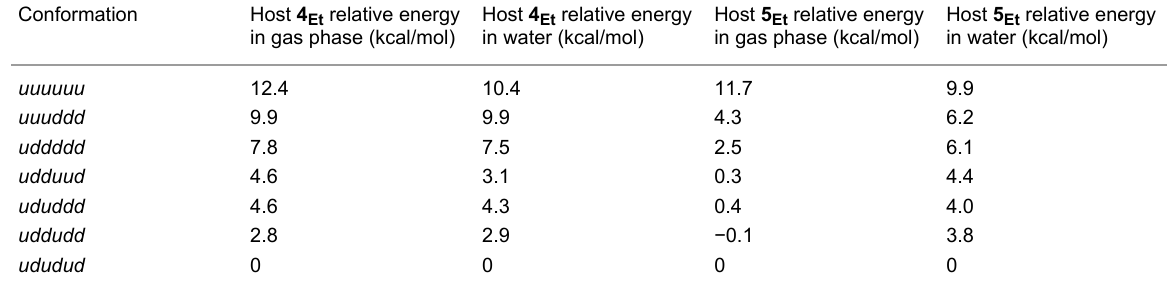
Table 5: Calculated energies for conformations of test hosts 4 Et and 5 Et . Conformation